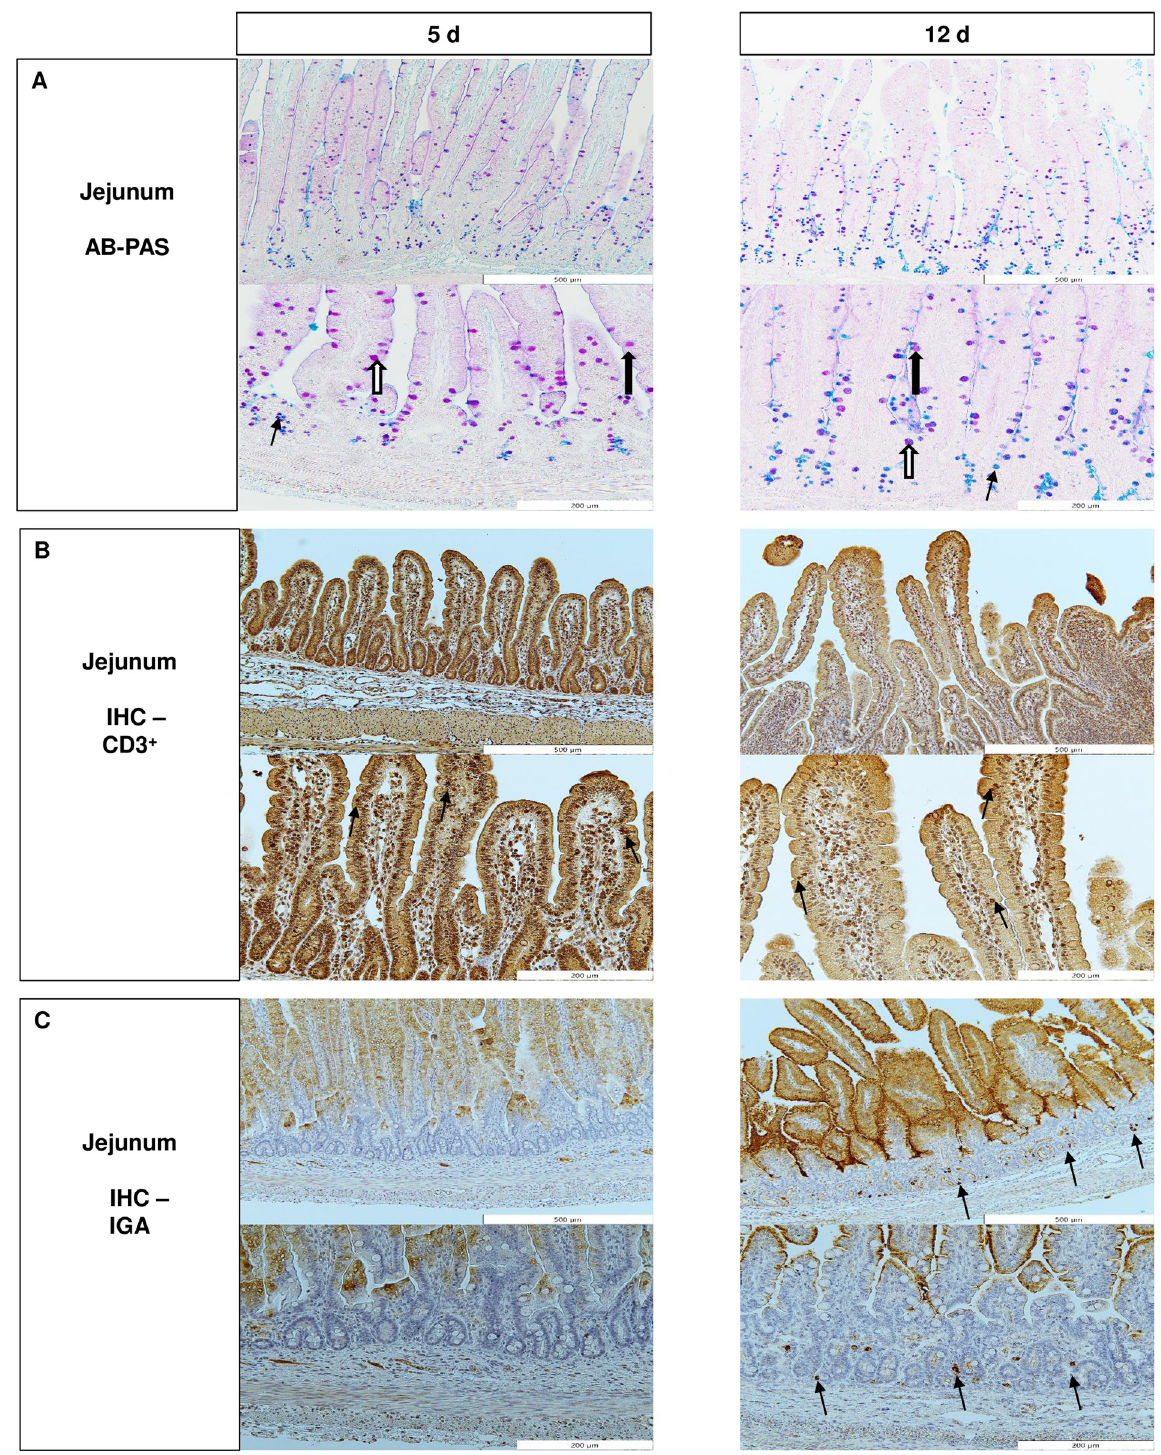
Fig 1. Jejunal Histomorphology and Immunohistochemistry (IHC) of 5 d and 12 d old male suckling piglets. A Alcian blue pH 2.5 -periodic acid Schiff stained jejunal tissue with stained goblet cells, different arrows indicating goblet cells containing different mucins. Narrow arrow = acidic mucins, wide closed arrow = neutral mucins, wide open arrow = mixed mucins. 5 d, 12 d: upper picture 100 x, lower picture 200 x magnification. B IHC of CD3, arrows indicating positive stained intraepithelial CD3+ cells in villi. 5 d, 12 d: upper picture 100 x, lower picture 200 x magnification. C IHC of IgA positive stained cells in lamina propria, no IgA positive cells detected at day 5, arrows indicating IgA positive